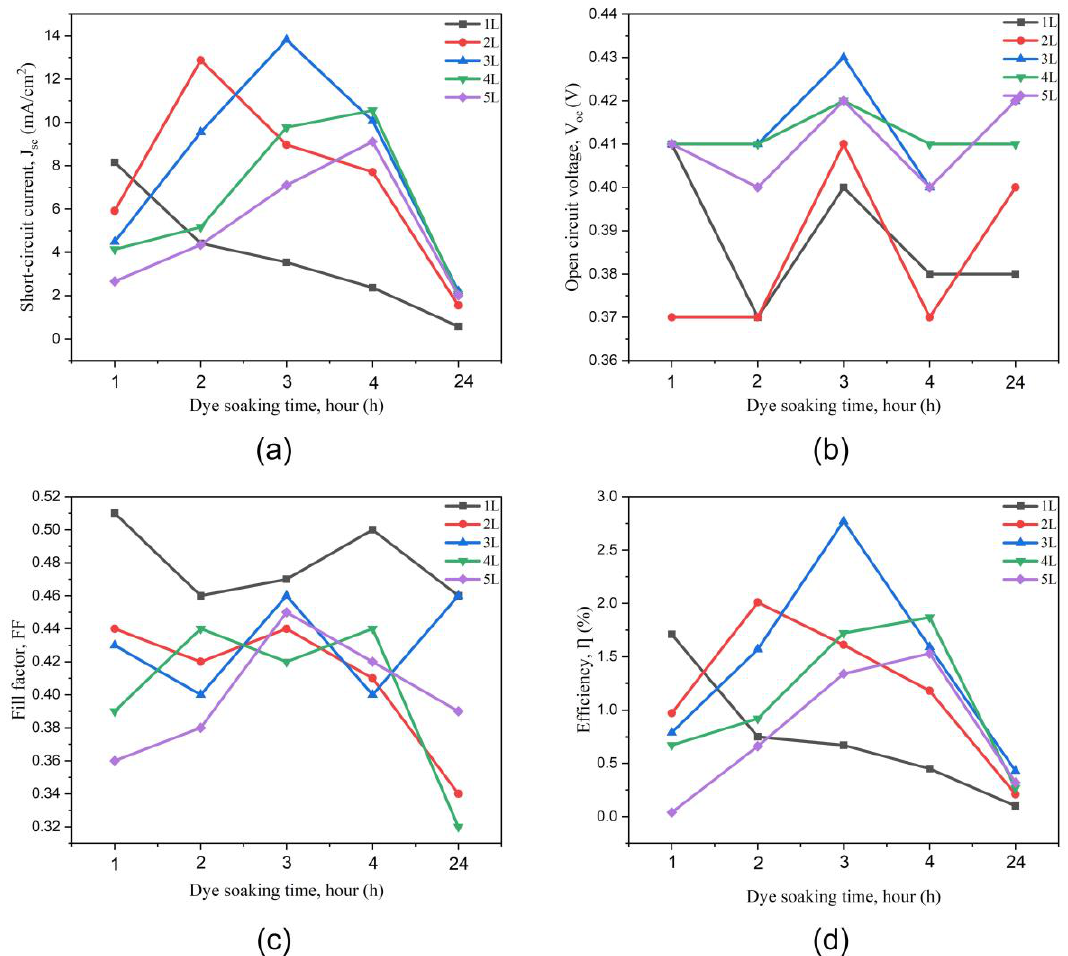
Figure 9. Relationship between the photovoltaic parameters of the ZnO DSSC on dye soaking time and the photoanode thickness: ( a ) J sc ( b ) V oc ( c ) FF , and ( d ) efficiency. The highest efficiency, 1.71%, was achieved by soaking the one-layered ZnO photoanode in the dye for an hour. In contrast, the highest efficiency, 2.77%, was achieved by soaking the three-layered ZnO photoanode in the dye for three hours, as shown in Table 2. Table 2. Photo-voltage characteristics for the cell at optimal dye soaking time for each layer. No. of